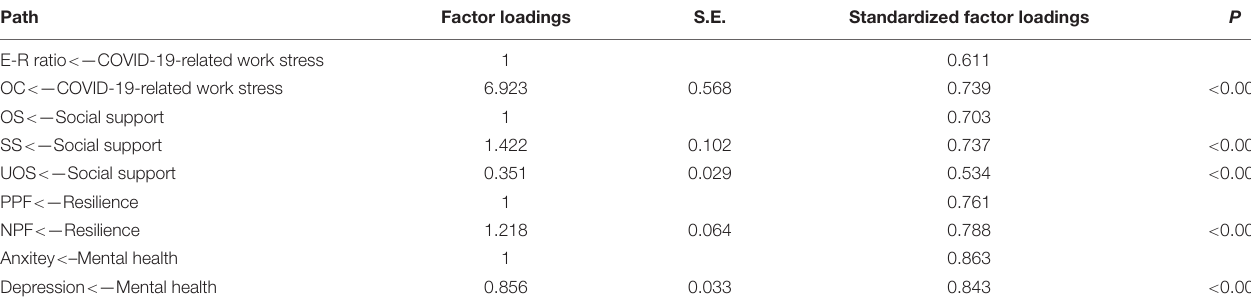
TABLE 3 | Maximum likelihood parameter estimates for measurement model.